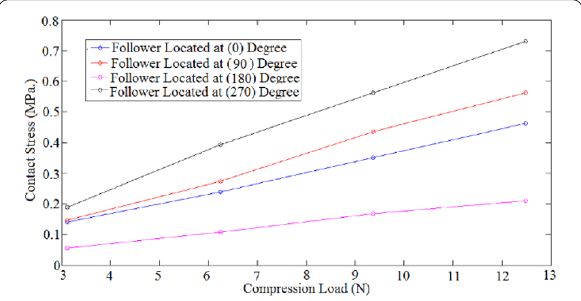
Figure 26 Contact stress is varying with compression load at different locations of the roller